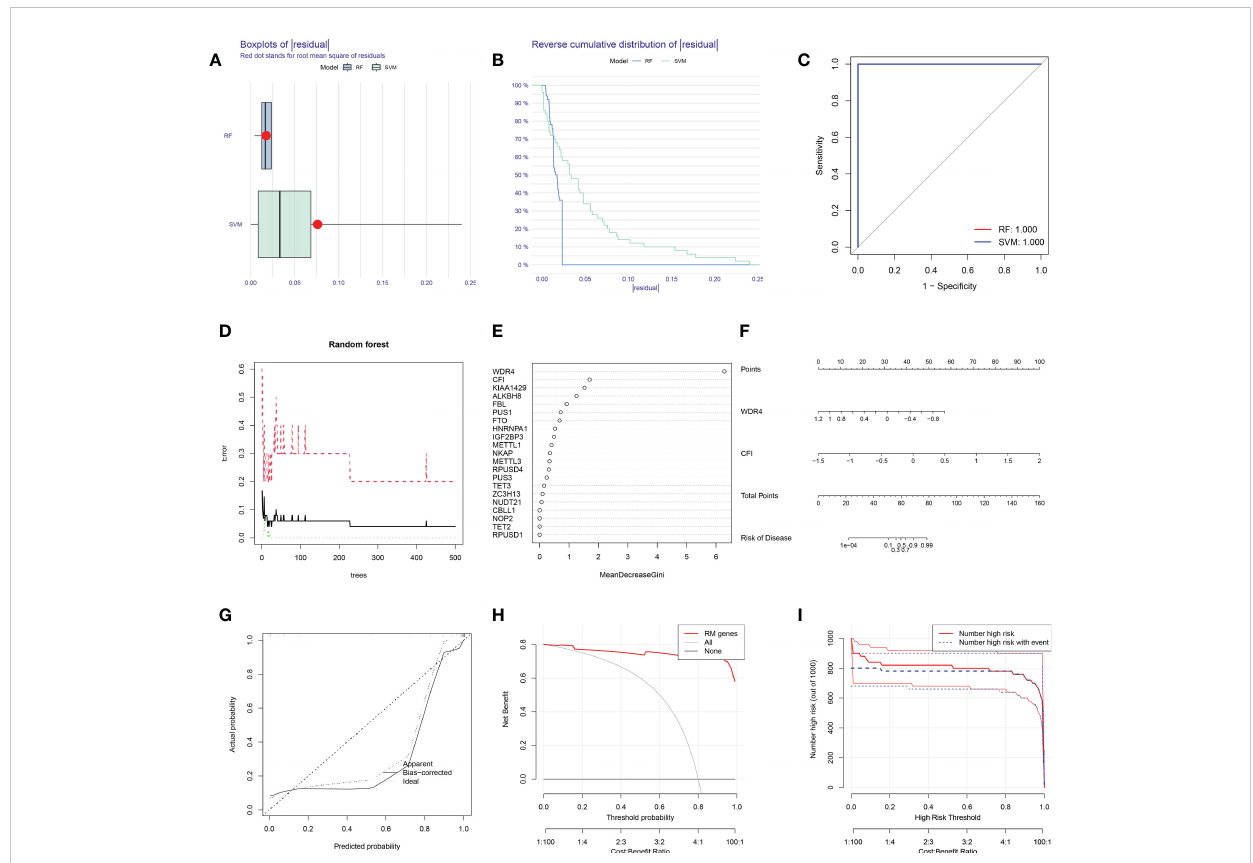
FIGURE 2 SVM and RF methods were used to construct OA predictive models. (A, B) Boxplot of the residual distribution (A) and reverse cumulative distribution of residuals (B) as a function of the values of observed sensitivity between RF and SVM. (C) ROC curves showing predictions for the SVM and RF models. (D) RF prediction error curves based on 10-fold cross-validation. (E) The importance of the 21 RNA modi fi cation regulators based on the RF model. (F) Nomogram of the predictive model based on two RNA modi fi cation regulators. (G) Calibration curves showing that the nomogram model may be an ideal predictive model for OA. (H, I) DCA (H) and clinical impact plots (I) were used to determine the clinical utility of the risk prediction nomograms. SVM, support vector machine; RF, random forest; OA, osteoarthritis; ROC, receiver operating characteristic; DCA, decision curve analysis; RM, RNA modi fi